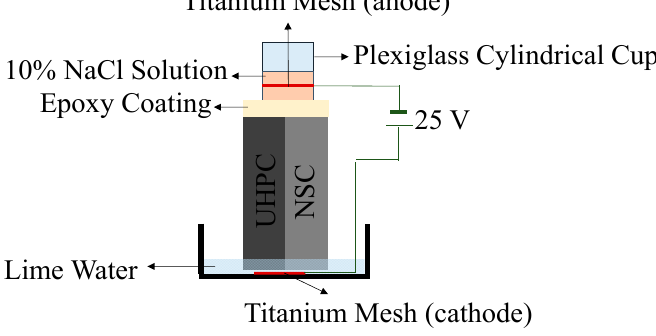
Figure 2. Experimental setup for the rapid chloride penetration test.